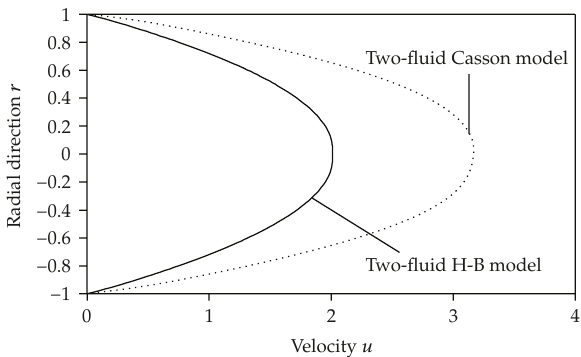
Figure 6: Velocity distribution of the two-fluid Casson and two-fluid Herschel-Bulkley